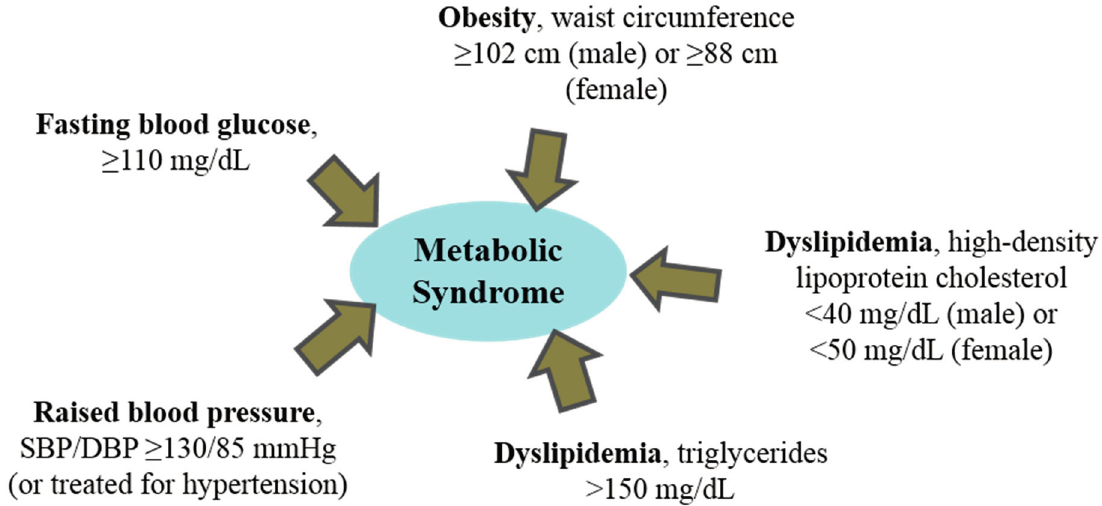
Figure 1. Dyslipidemia, abnormal endogenous lipid metabolism (including